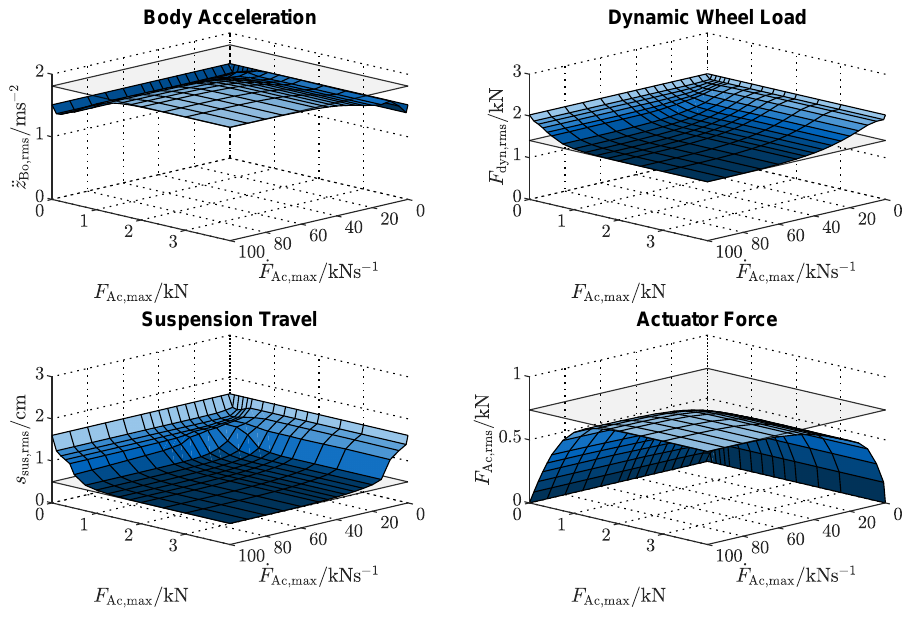
Figure 18. RMS surface plots for the 90kmh − 1 AB profile dynamic wheel-load optimization scenario.